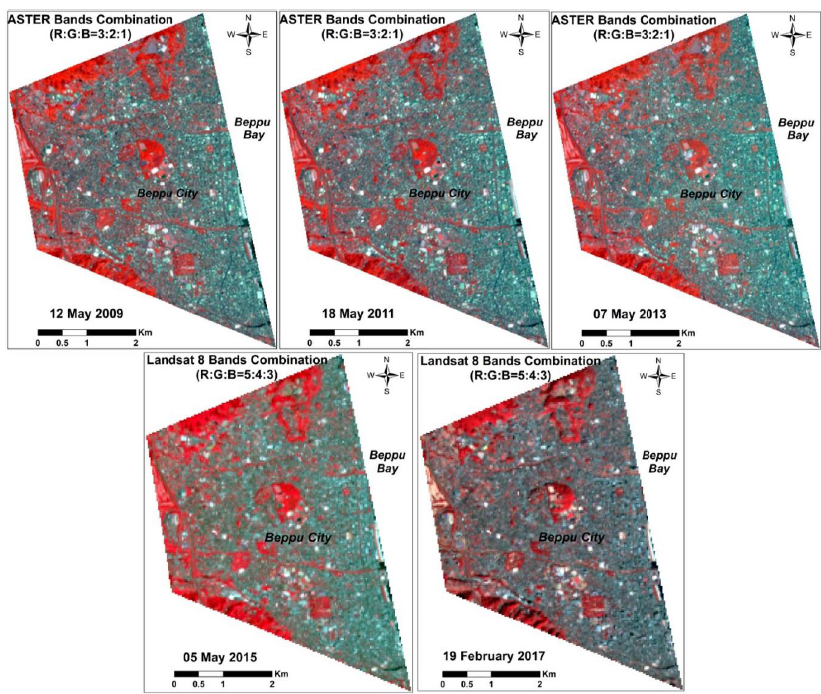
Figure 11. Top row: False color composite of RGB of NIR-visible bands of ASTER satellite images of the Beppu geothermal area for 2009, 2011, and 2013. Bottom row: Band composite of RGB of NIR-visible bands of Landsat 8 OLI of the Beppu geothermal area for 2015 and 2017.